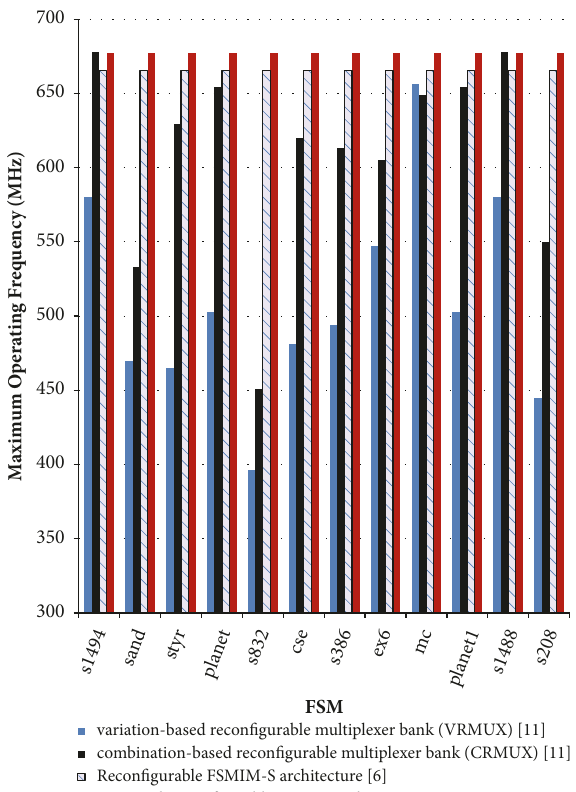
Figure 7: Comparative analysis of maximum operating frequency on FPGA